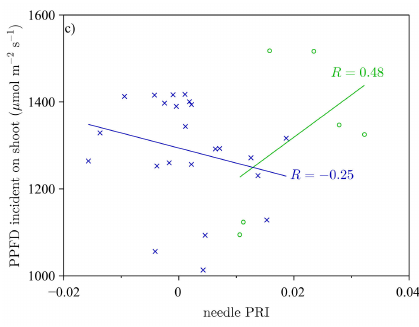
Figure 5. The correlation between needle PRI and ( a ) the sunlit shoot light use efficiency ε ; ( b ) photosynthetic assimilation P ; and ( c ) PPFD. Measurements at high light levels (PPFD > 1000 µ mol m − 2 s − 1 ); P and ε are normalized by their maximum value for each campaign.